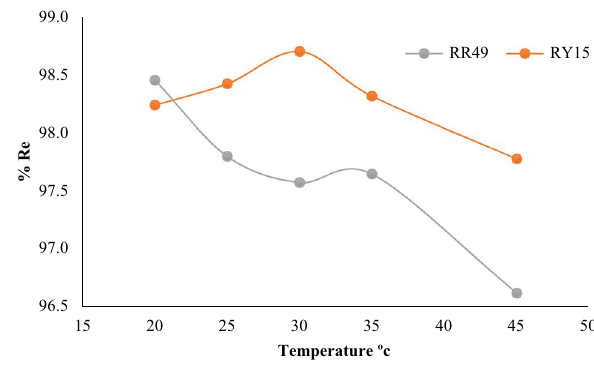
Fig. 10 Effect of speed of agitation on % Re of dyes